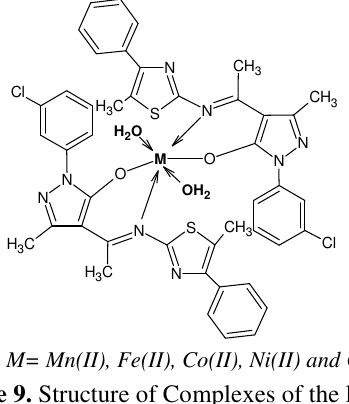
Figure 9. Structure of Complexes of the ligand